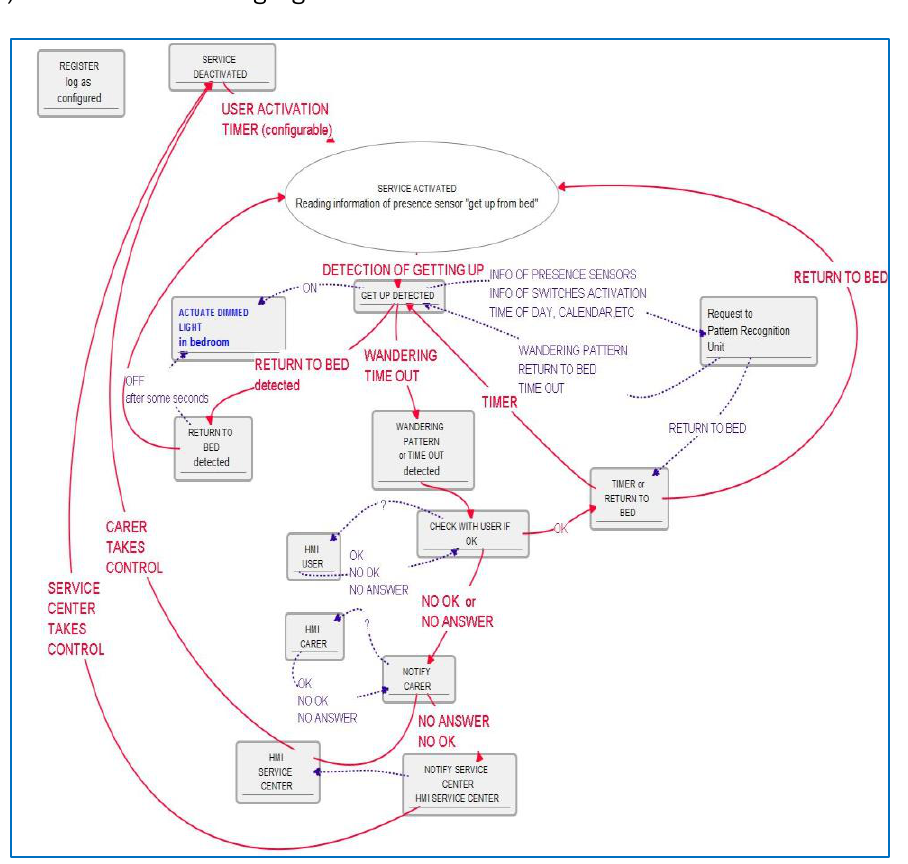
Figure 7. Simplified algorithm for night falls and wandering prevention; actions flow is in red lines; information exchanging is in blue-dotted